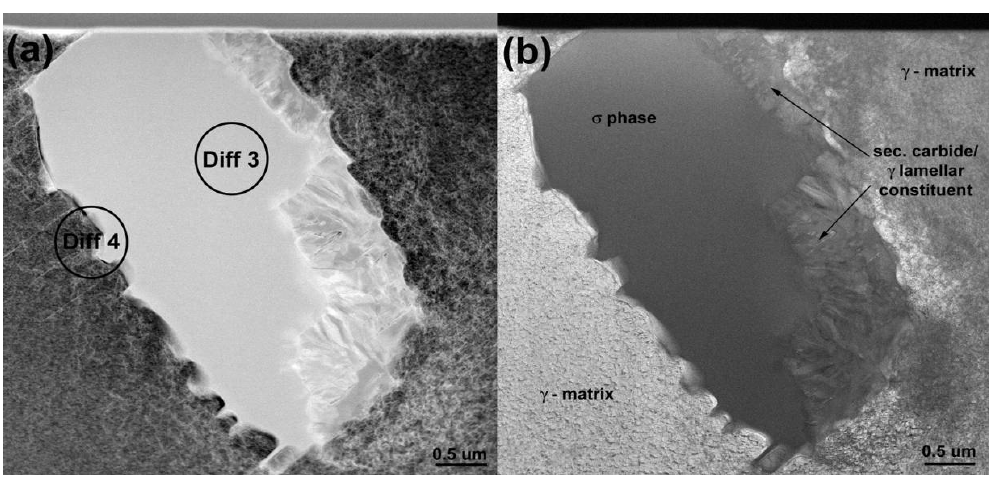
Figure 9. Microstructure of σ phase particles: ( a ) HAADF-STEM and ( b ) BF-STEM.